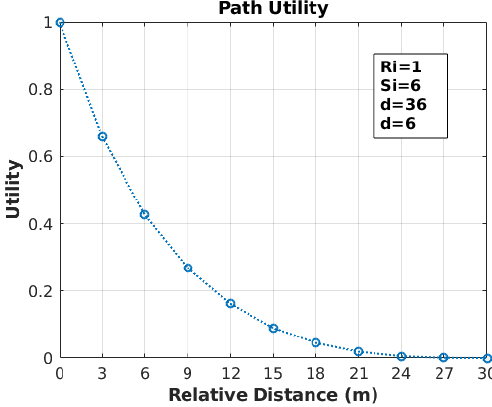
Figure 5. Path utility function behaviour. There are several tasks in the scene (blue circles). The closest is located 6 m away from the robot while the furthest is 36 m far away. The closest and furthest tasks always return 1.0 and 0.0, respectively.